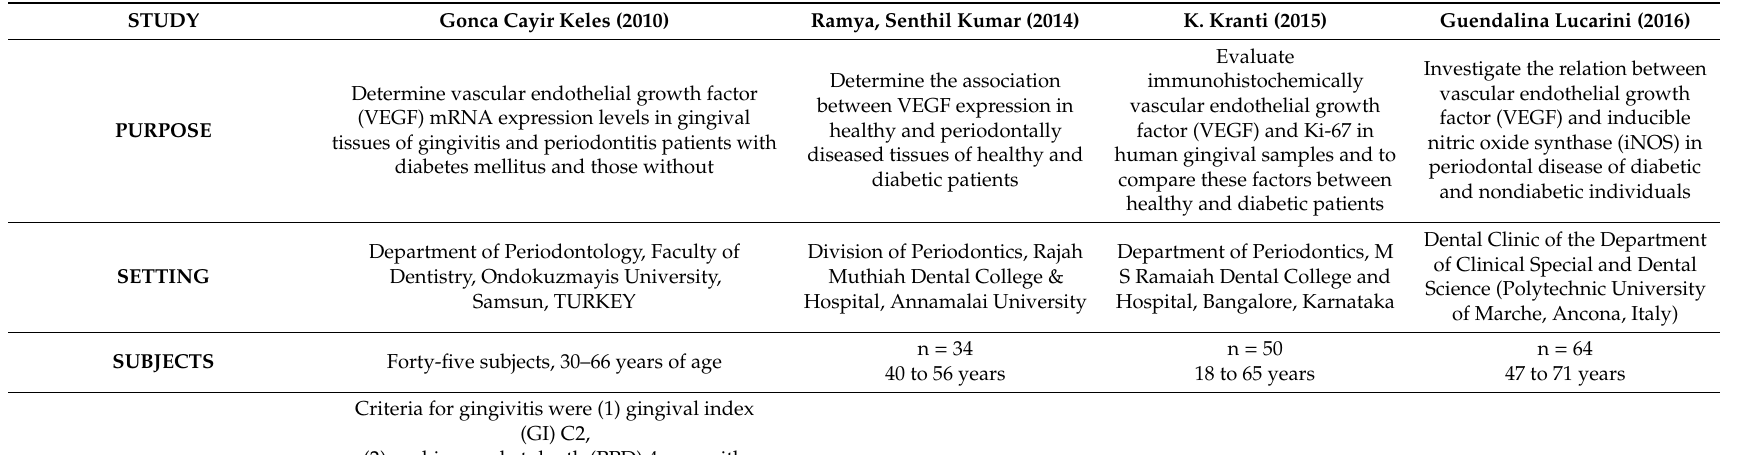
Table 2. Data extraction